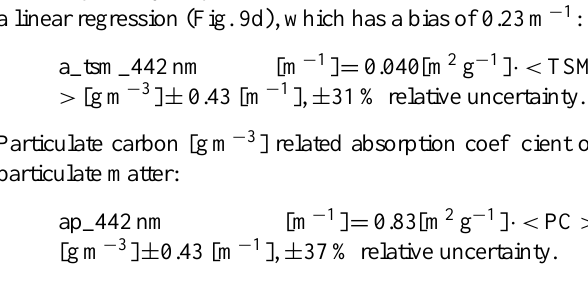
Absorption by all particles (TSM) at 442 nm derived from a linear regression (Fig. 9d), which has a bias of 0.23 m − 1